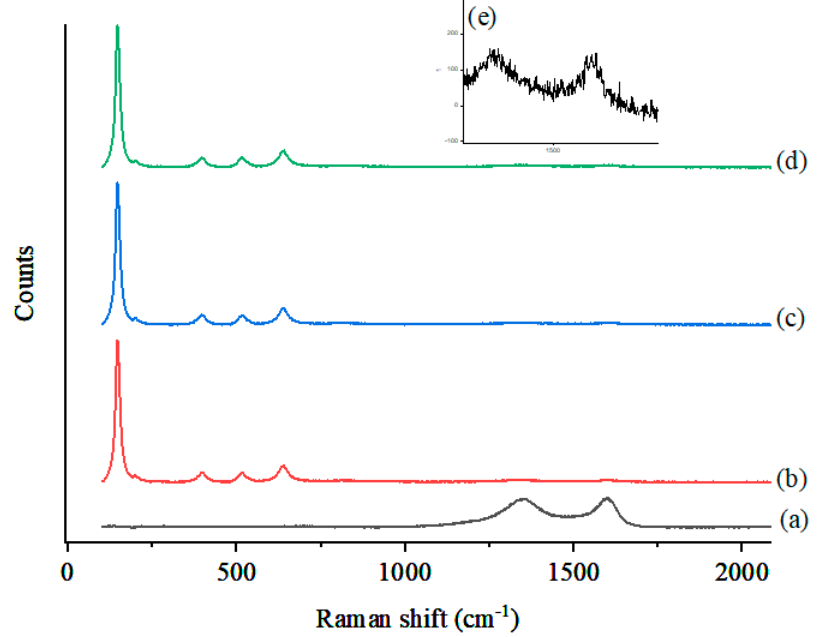
/ AC and Fe / AC / TiO 3 O 4 3 O 4 2 in ratios of ( b ) 1:1, ( c ) 1:2, and ( d )